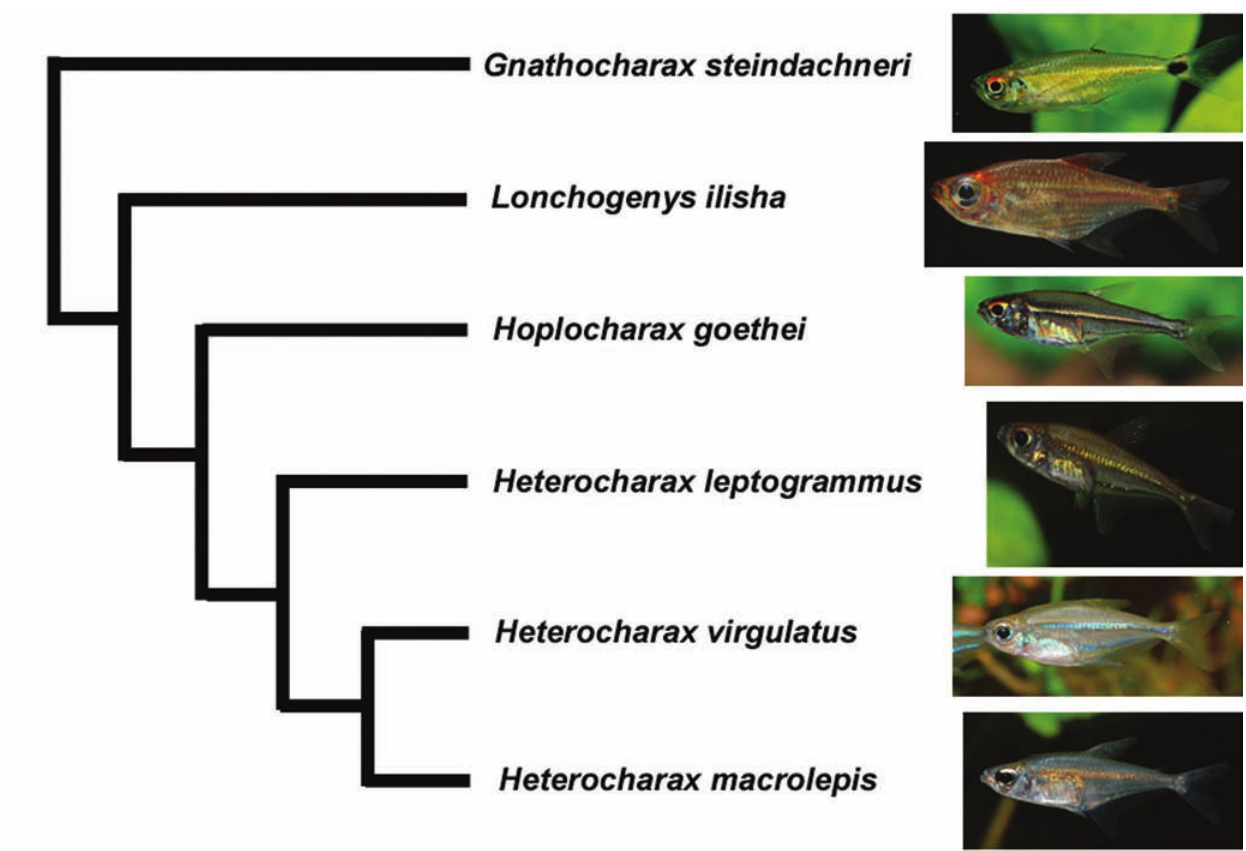
Fig. 2. Phylogenetic relationships within the tribe Heterocharacini excluding Priocharax , modified from Mattox & Toledo-Piza